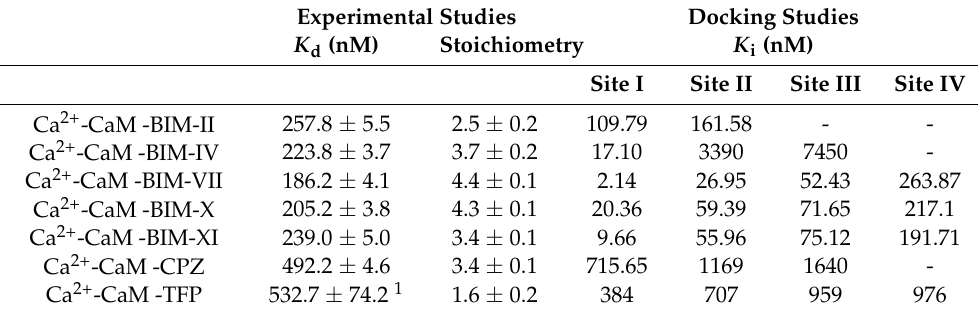
Table 1. Experimental and theoretical binding properties of Ca 2+ -CaM-BIMs complexes. Experimental